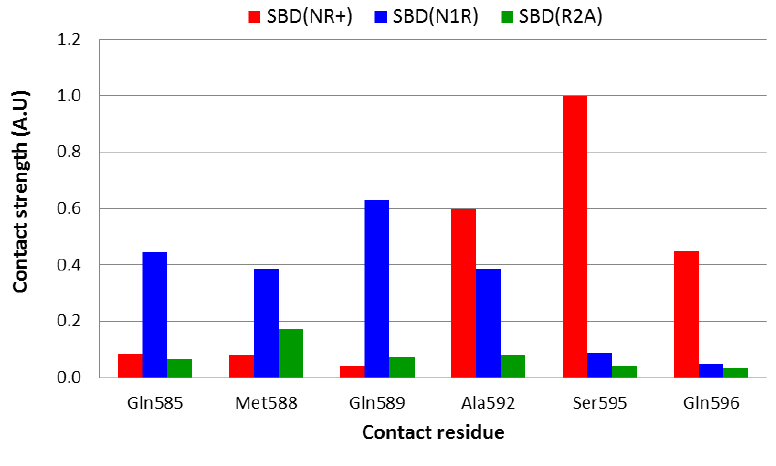
Figure 5. Normalized strength of interaction between the peptide and the lid, for the DnaK-SBD-Peptide simulations. The calculations were carried out using Asn 1 (of the peptide) as the point of reference, and the strength parameter was calculated according to Equation (6). For comparative purpose the value of the strength parameter calculated for the interaction of S 595 with Asn 1 was defined as 1, and all others were scaled appropriately. The results represent the last 10 ns of each simulation, when the system had reached a stable conformation. The presentation is limited to only six residues which were closest to N 1 residue of the peptide. The color code is defined in the